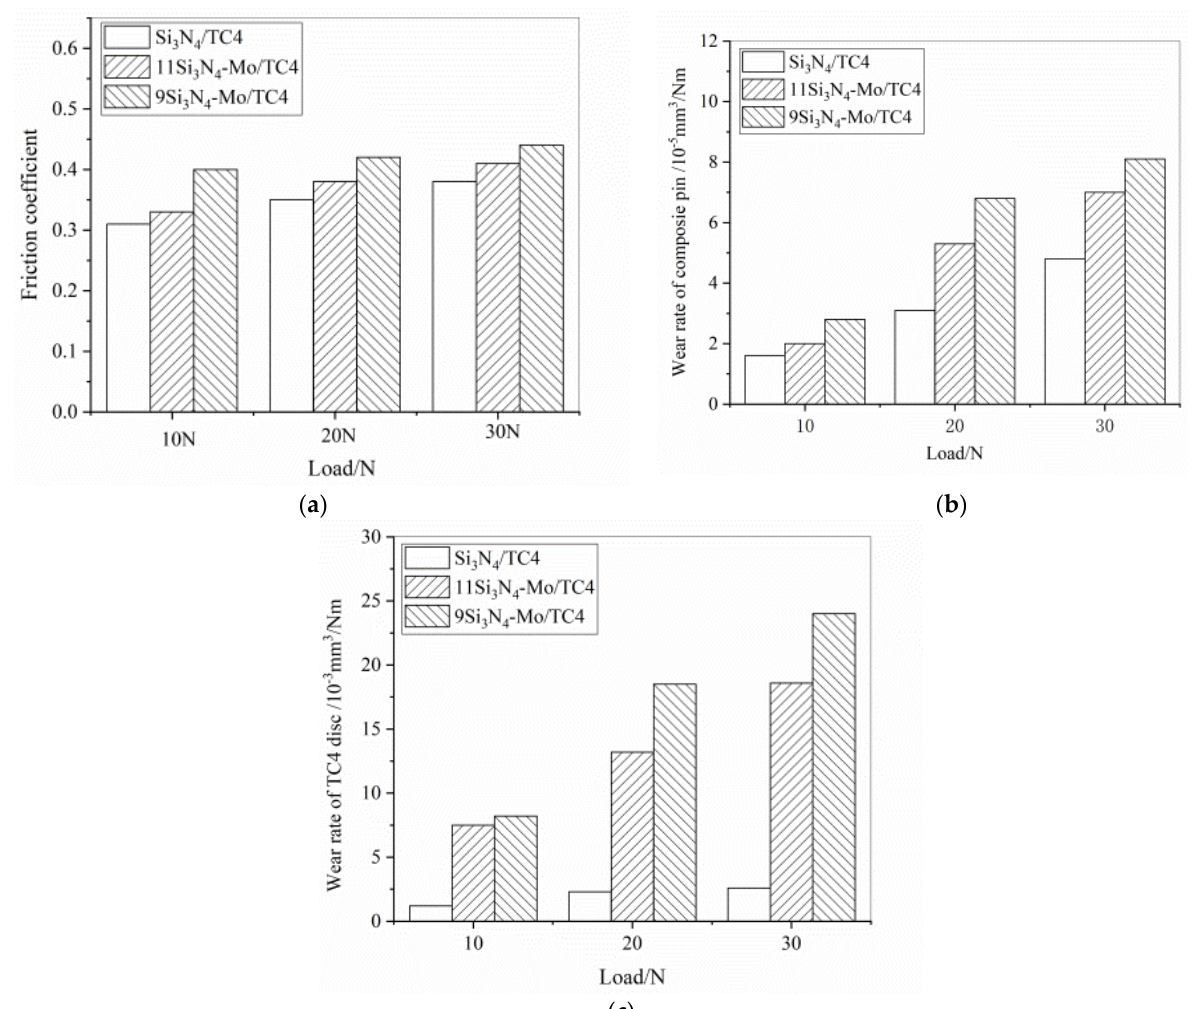
Figure 8. Friction coefficient ( a ), wear rate of pin ( b ) and disc ( c ) for Si 3 N 4 /Mo-laminated composite sliding against TC4 pairs in artificial seawater.